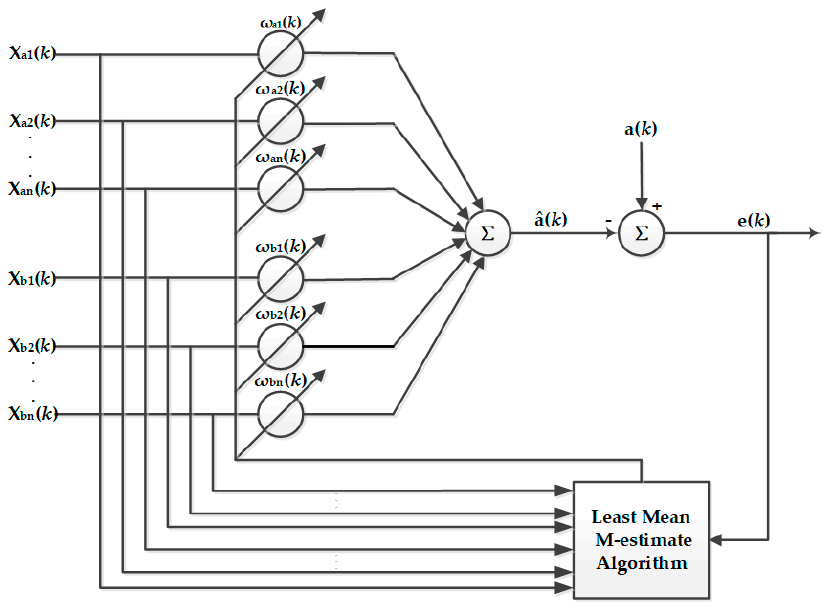
Figure 4. Harmonic identification scheme using Adaline LMM algorithm.